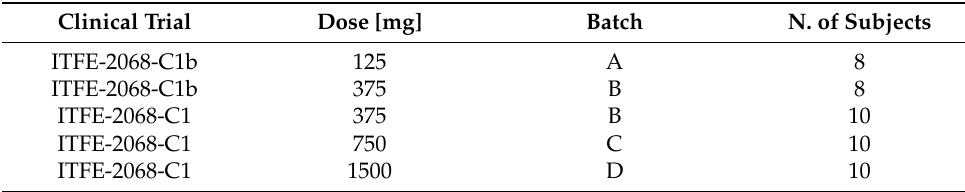
Table 2. Information summary of the considered clinical studies. Clinical